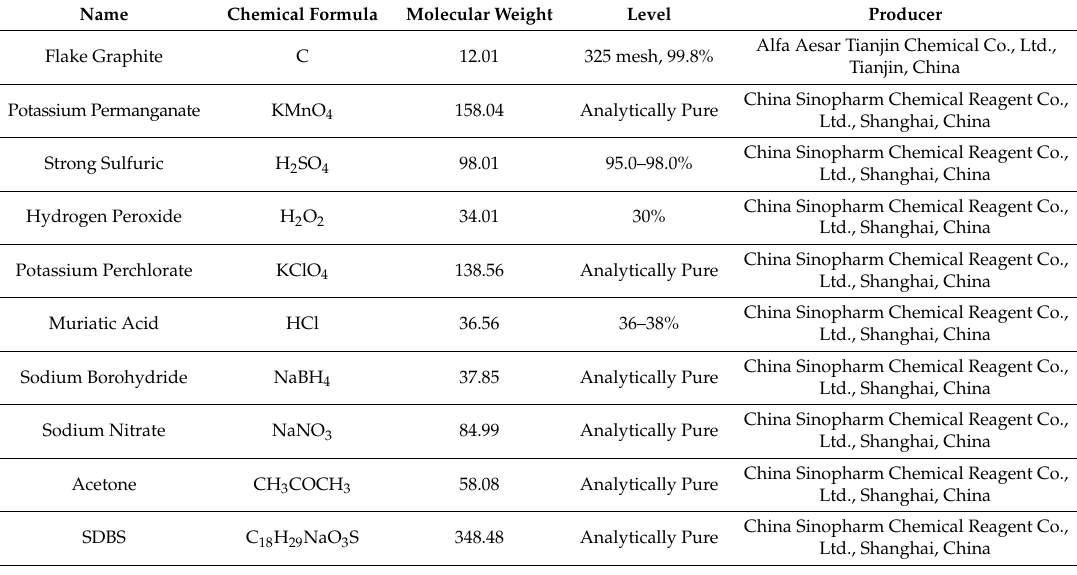
Table 1. Chemicals used in the experiment. SDBS: sodium dodecyl benzene sulfonate.